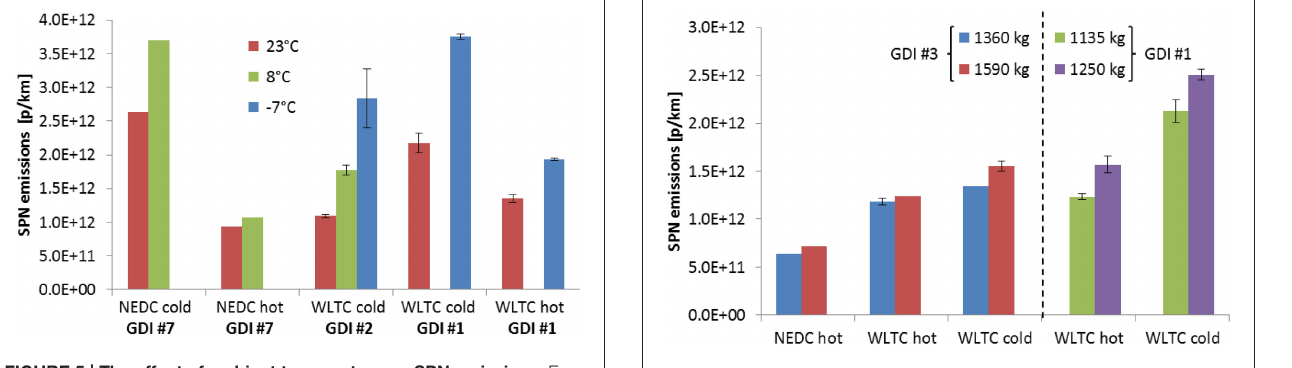
FIGURE 6 | Effect of vehicle load (simulated here by chassis dynamometer inertia) on the SPN emissions of Vehicles GDI #1 and #3. Error bars indicate the minimum and maximum emissions of three (Vehicle GDI #1) and two (Vehicle GDI #3) test repetitions. Tests were conducted in the laboratory with PMP-CVS